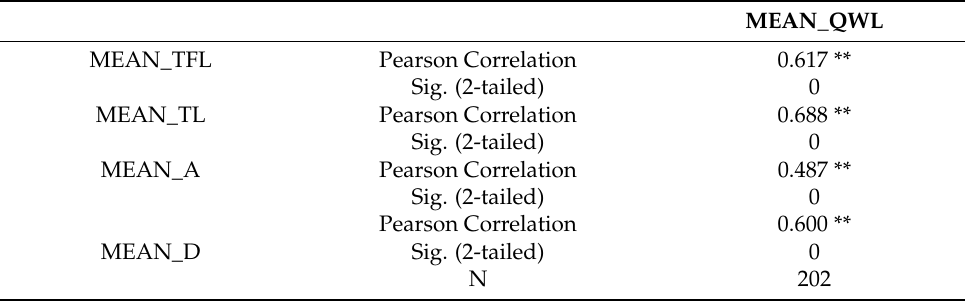
Table 2. Correlation Analysis of Leadership Style and QWL.